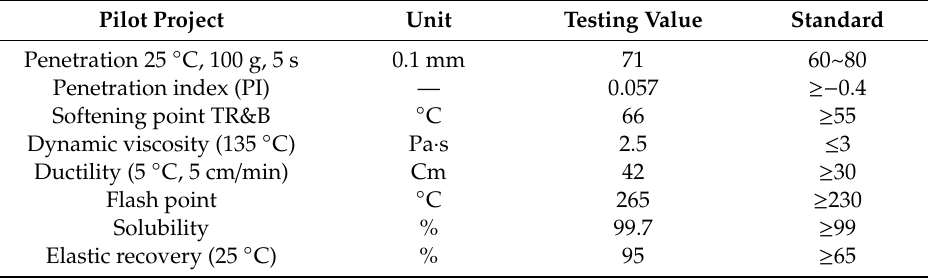
Table 4. Technical indices of SBS-modified